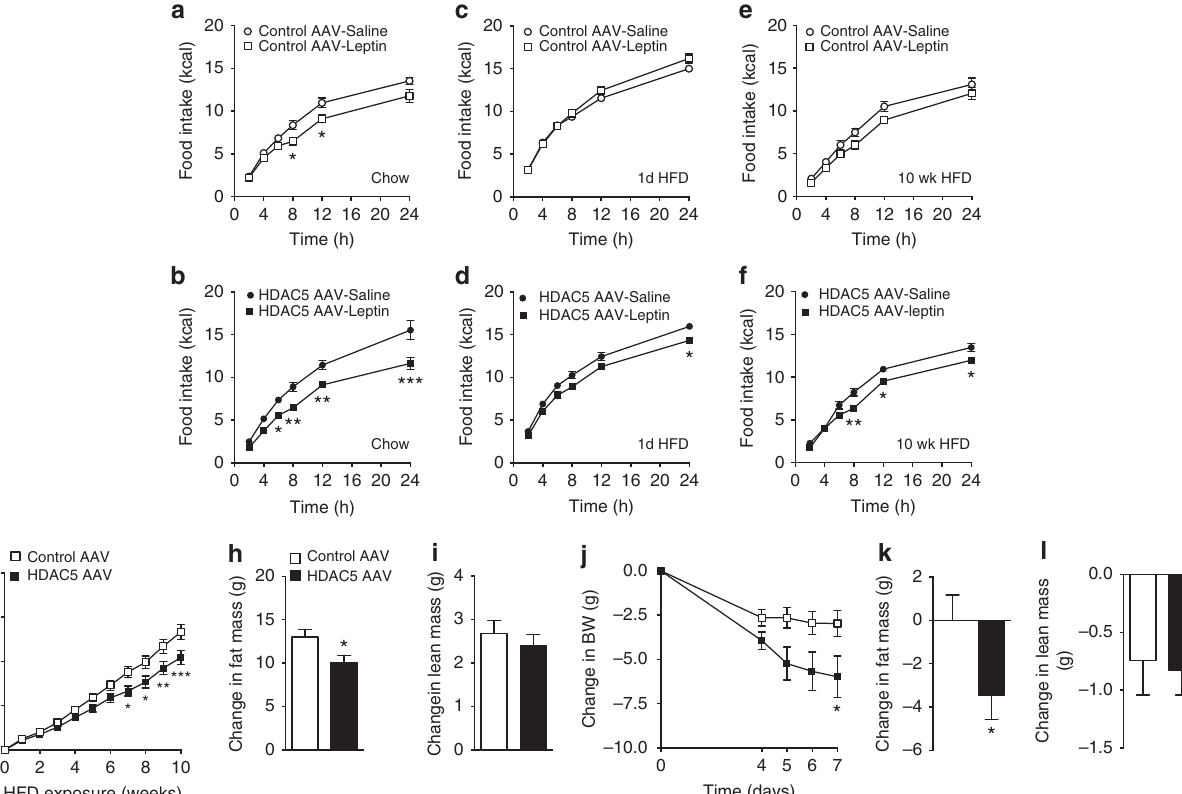
Figure 6 | Hypothalamic HDAC5 overexpression improves leptin sensitivity and ameliorates diet-induced obesity: One week after AAV-mediated overexpression of HDAC5 or control GFP in the MBH, chow-fed male C57BL/6J mice ( a , b ) were administered i.p. with leptin (5mgkg (cid:2) 1 ) or PBS, and food intake was assessed for 24h ( n ¼ 7–8). The same mice were subsequently exposed to HFD feeding, subjected to leptin challenge tests (PBS versus Leptin 5mgkg (cid:2) 1 ) after 1 day ( c , d ) and after 10 weeks ( e , f ) of HFD exposure, and monitored for body weight gain ( g ), fat mass gain ( h ) and lean mass changes ( i ). Changes in body weight ( j ), fat mass ( k ) and lean mass ( l ) were monitored in male DIO mice after AAV-induced HDAC5 overexpression in the MBH, compared with AAV–GFP control mice ( n ¼ 10–11). Values represent means ± s.e.m. Statistical analyses were done by using two-way ANOVA followed by